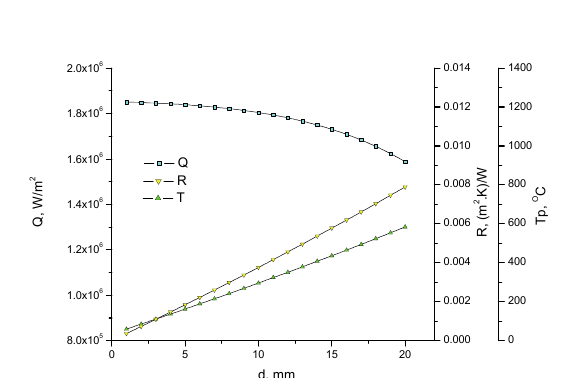
Figure 9: Heat losses, surfaces temperature and thermal resistance of insulation as a function of magnesite-chromite